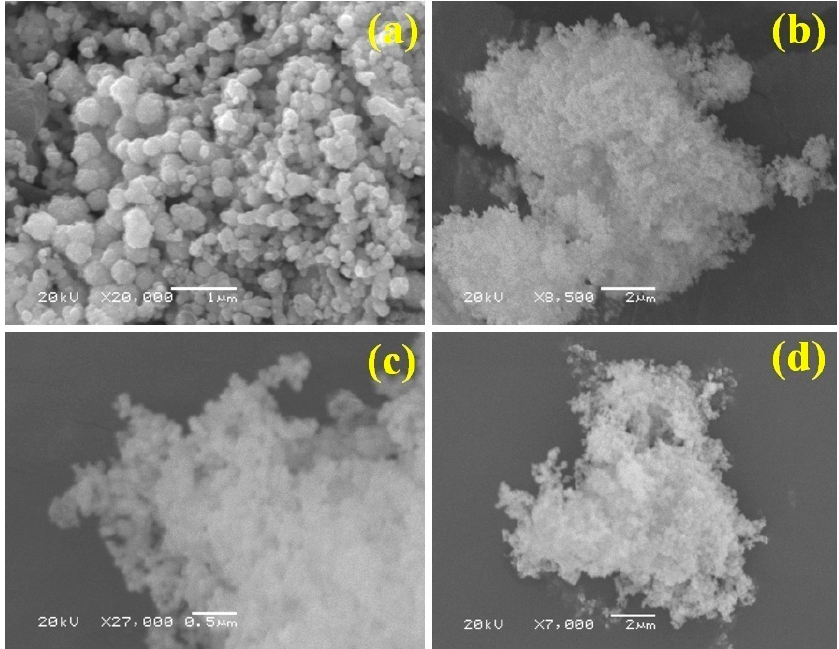
Figure 3. Scanning electron microscopy (SEM) micrographs of the ( a ) Ni nanoparticles, ( b ) bare CWO, and ( c , d ) CWO–Ni3 composite.